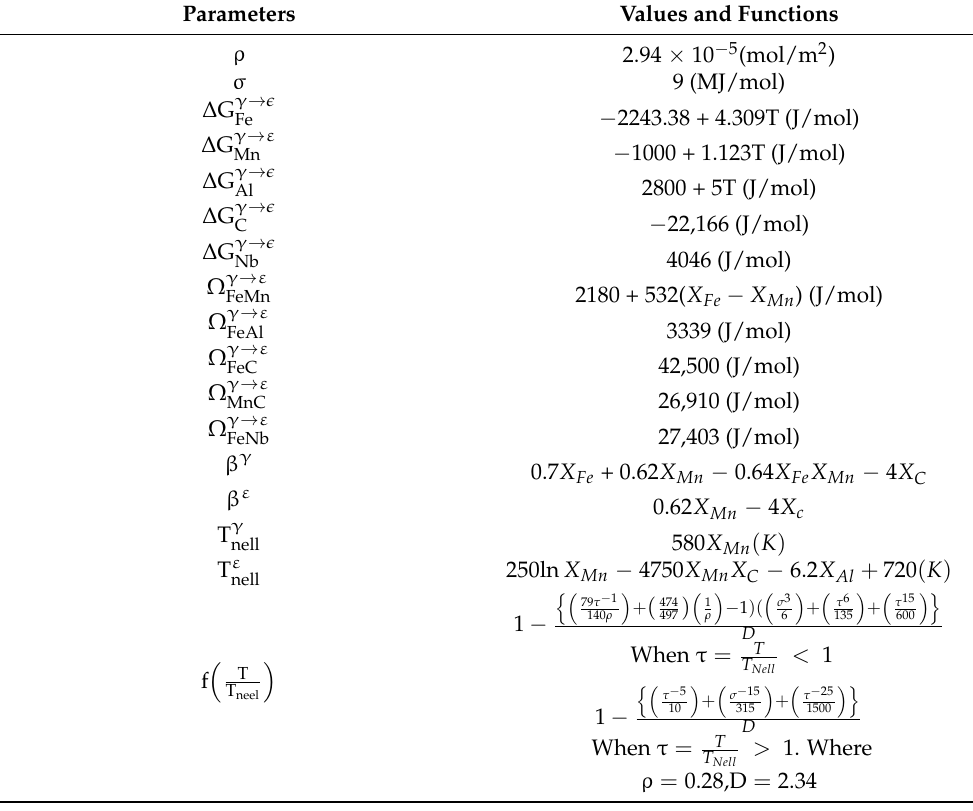
Table 2. The values used for the estimation of the stacking fault energy (SFE) of Fe–28Mn–10Al–C– 0.5Nb steel by Equations (1), (4), and (7)